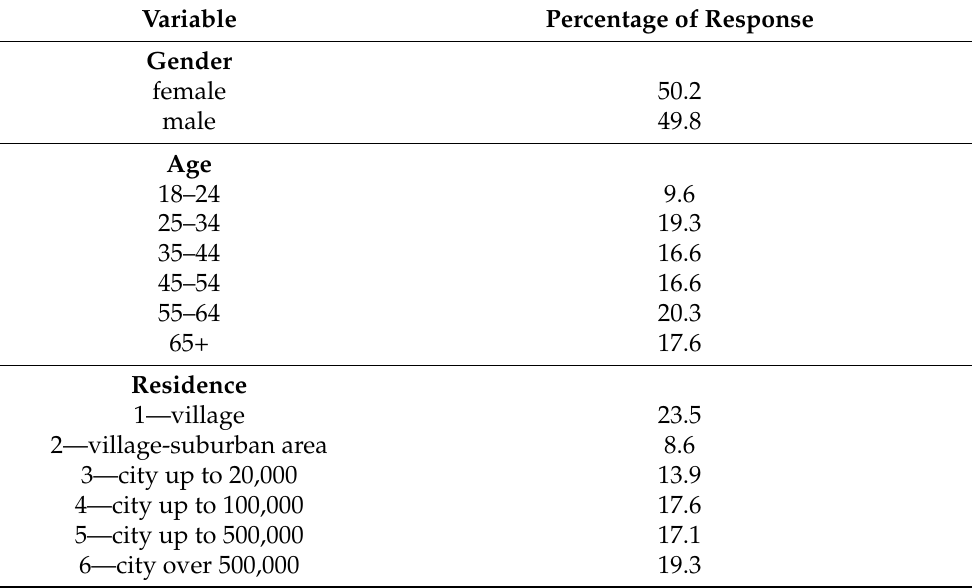
Table 1. The frequency distribution for sociodemographic variables in the sample